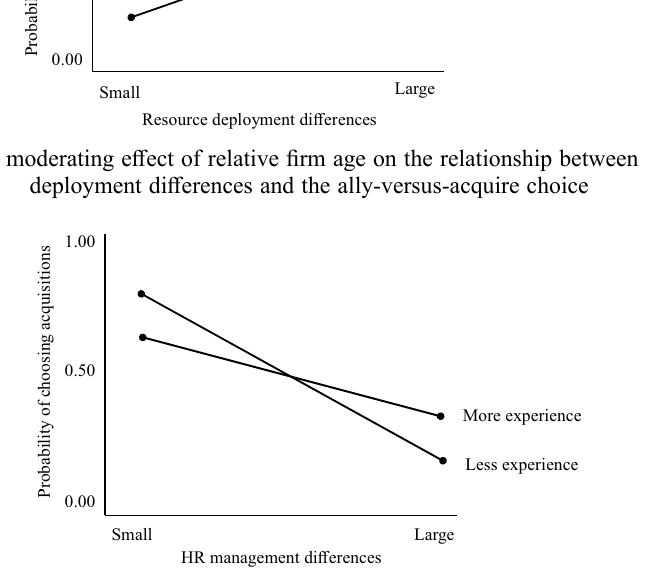
Fig. 3. The moderating effect of interfirm governance experience on the relationship between HR management differences and the ally-versus-acquire